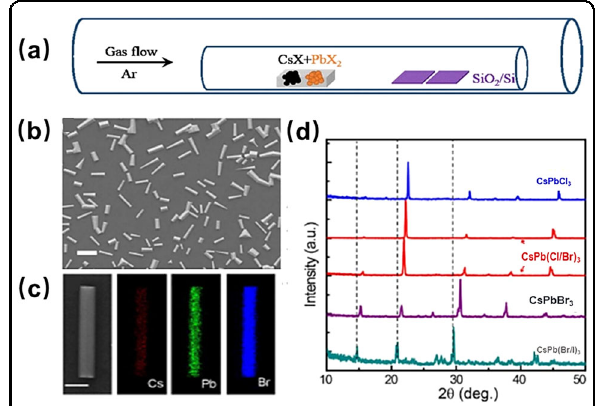
Fig. 3 Growth of 1D morphological MHP by vapor phase methods. a Schematic diagram for vapor growth of CsPbX 3 micro/ nanorods. b SEM image showing as-prepared CsPbBr 3 perovskite NRs. c SEM image and corresponding energy dispersive X-ray (EDX) maps of an individual CsPbBr 3 NR. d X-ray diffraction (XRD) patterns for the as-prepared CsPbX 3 . Reproduced with permission from ref. 51